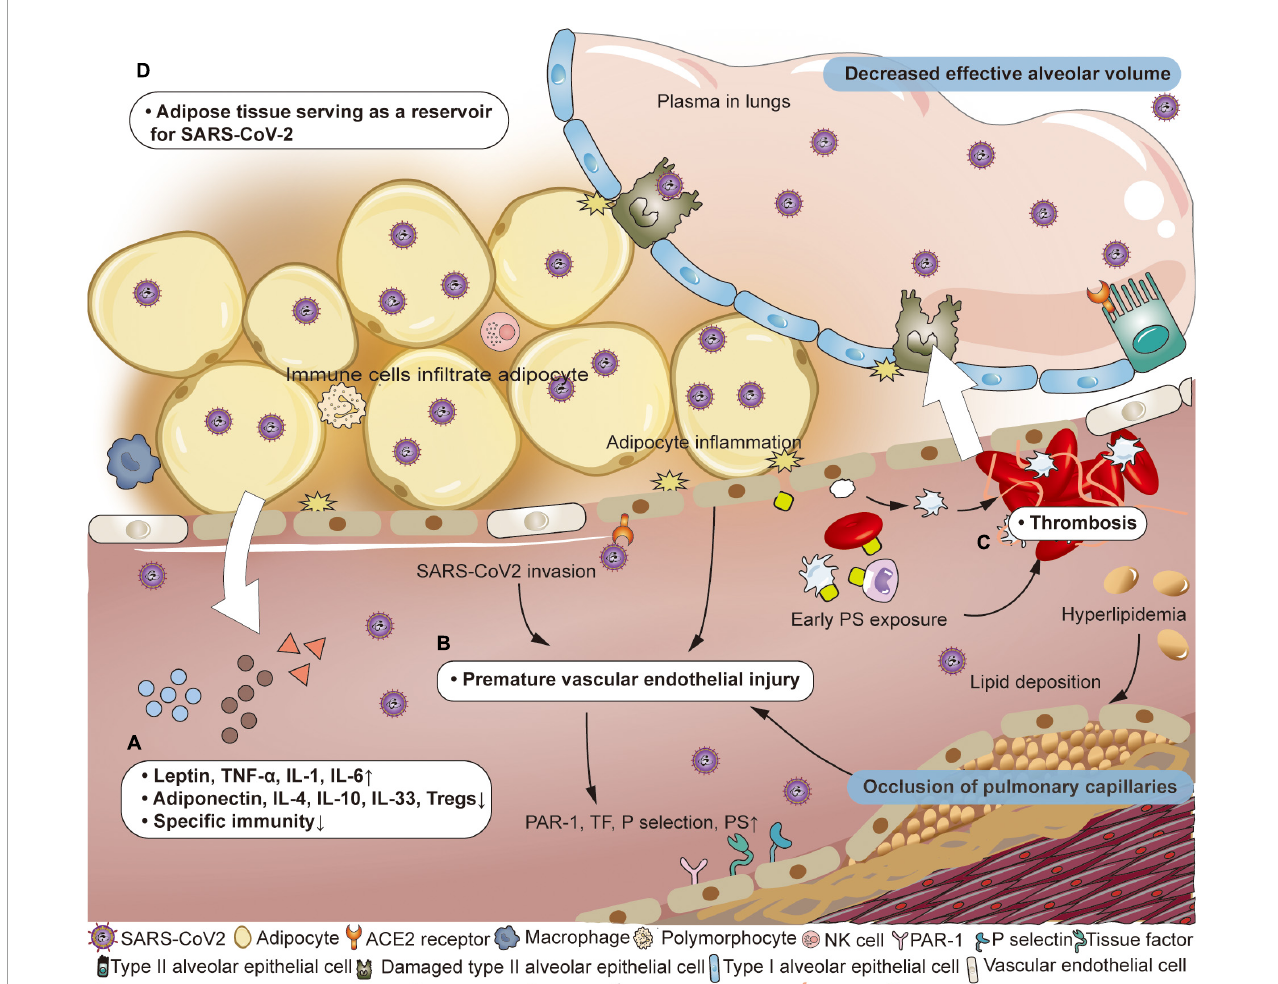
FIGURE1 Pathophysiological changes of air-blood barrier in obese patients with COVID-19. (A) Adipose tissue has the potential to serve as a reservoir for SARS-CoV-2. (B) Immunocytes infiltrate adipose tissue, producing inflammatory mediators and adipokines, accompanied by a weakened specific immune response. (C) Under the combined effects of virus invasion, inflammation of adipocytes and lipid deposition, vascular endothelial destruction occurs prematurely, and the vascular wall structure is destroyed. The expression of protease activated receptor 1 (PAR-1), tissue factor (TF), P selectin, and phosphatidylserine (PS) on endothelial cells is up-regulated. (D) PS exposure on vascular endotheliocyte, erythrocyte, platelet, neutrophil, and lymphocyte appears earlier and participates in thrombosis. Adapted from “Adipocyte (white),” by BioRender.com (2022). Retrieved from